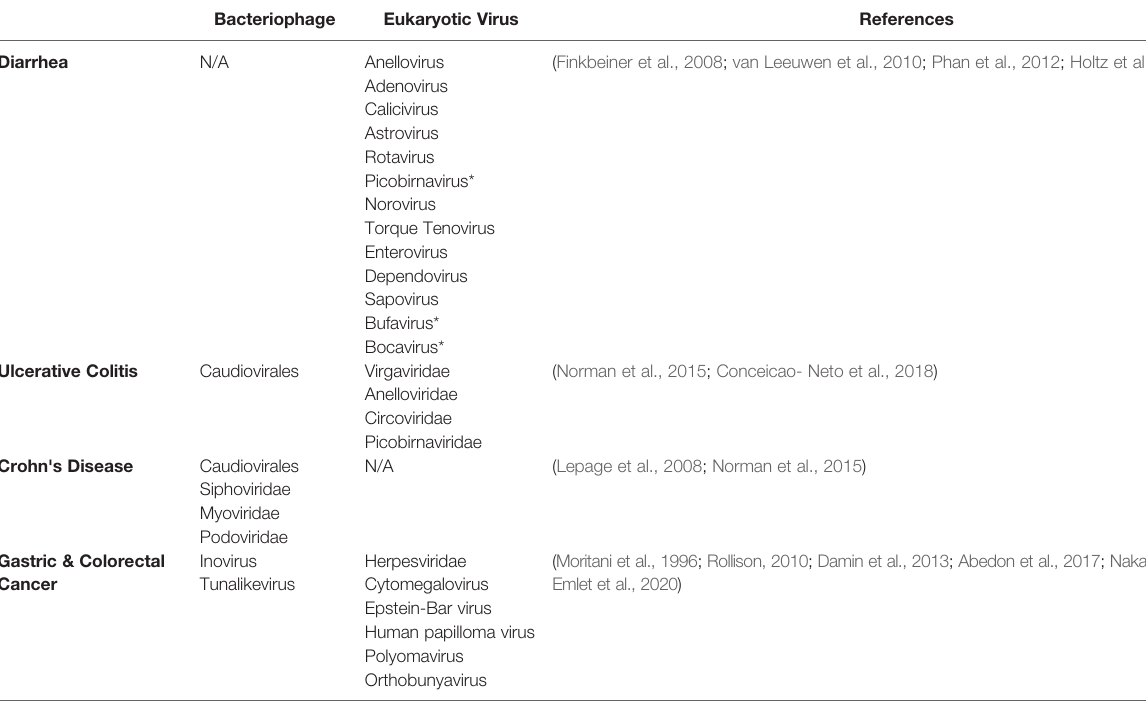
TABLE 1 | Increased viral loads associated with GI diseases (* indicates novel